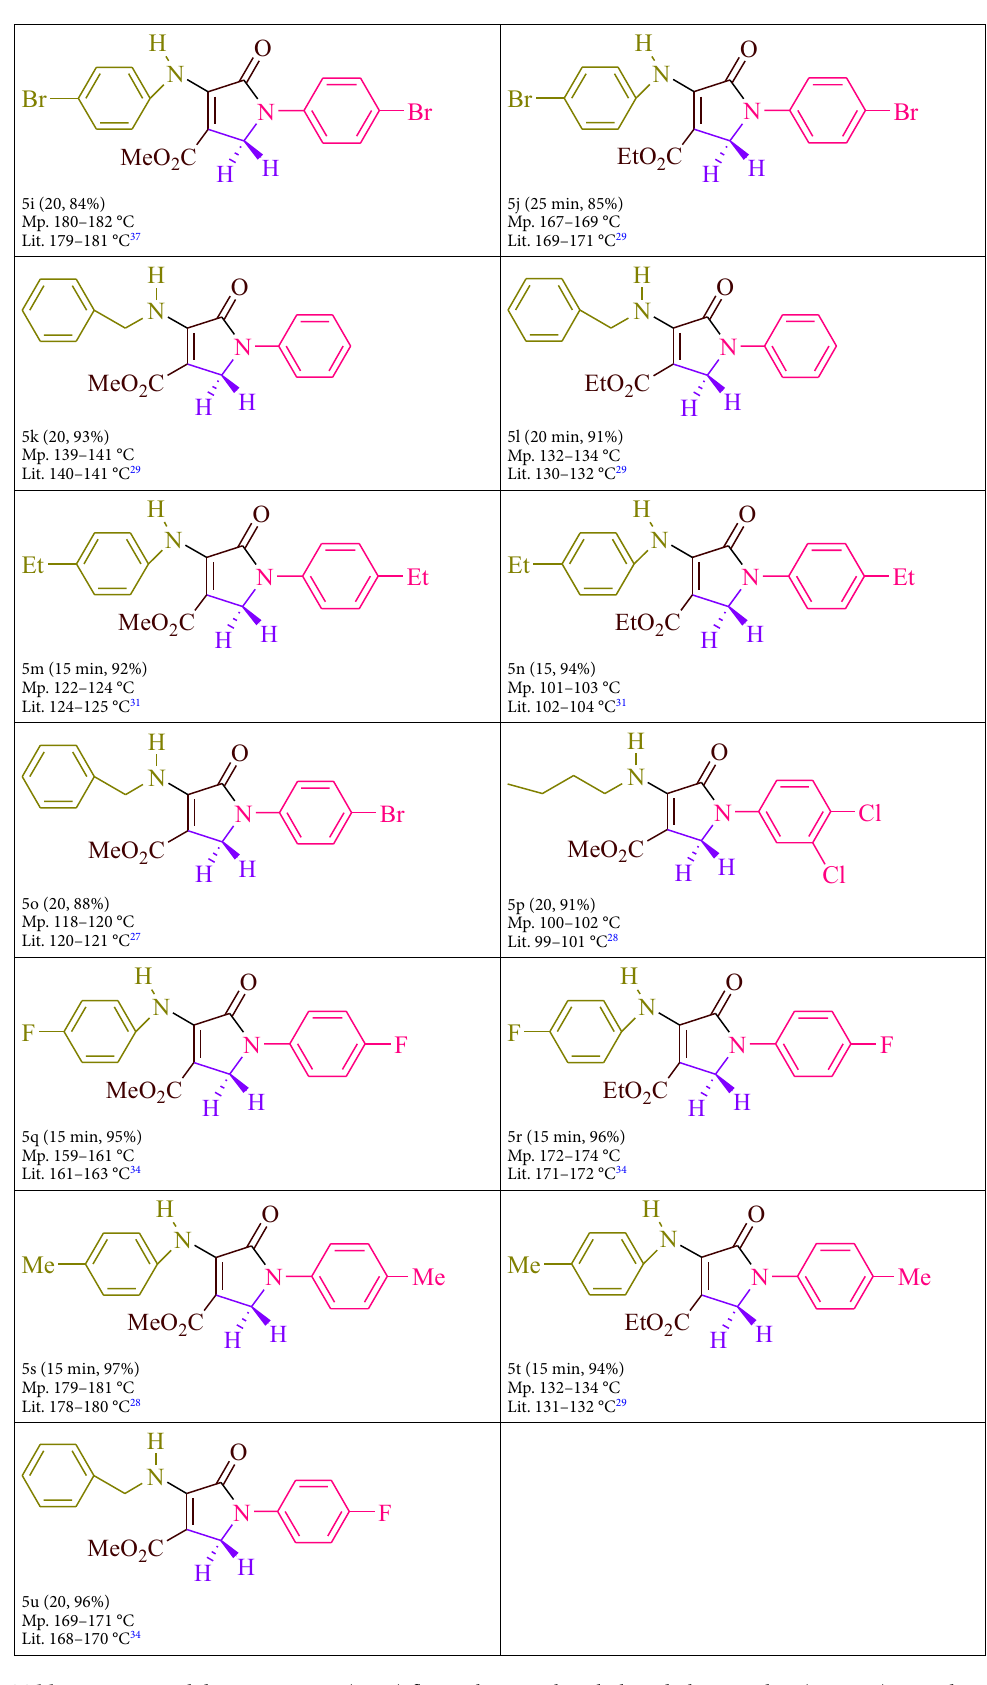
Table 3. As a novel donor–acceptor (D–A) fluorophore, carbazole-based photocatalyst (4CzIPN) is used to create polyfunctionalized